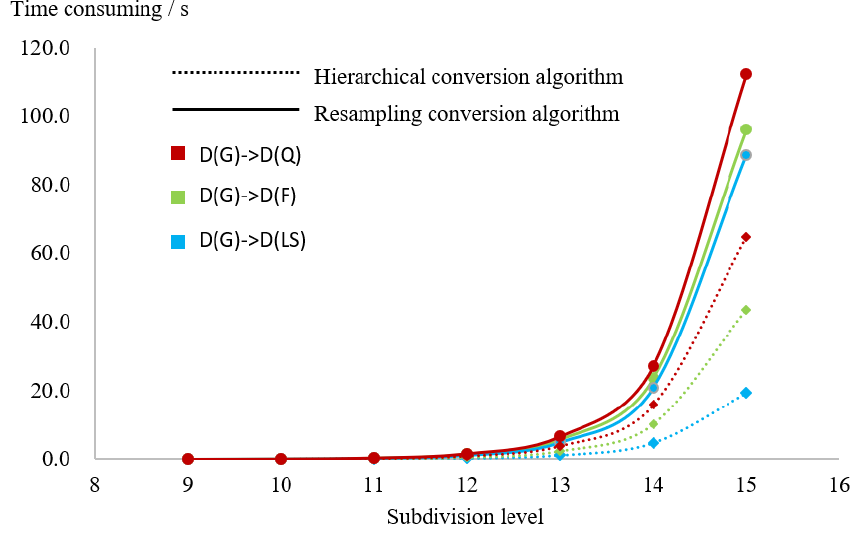
1 Resampling conversion algorithm. 2 Hierarchical conversion algorithm.